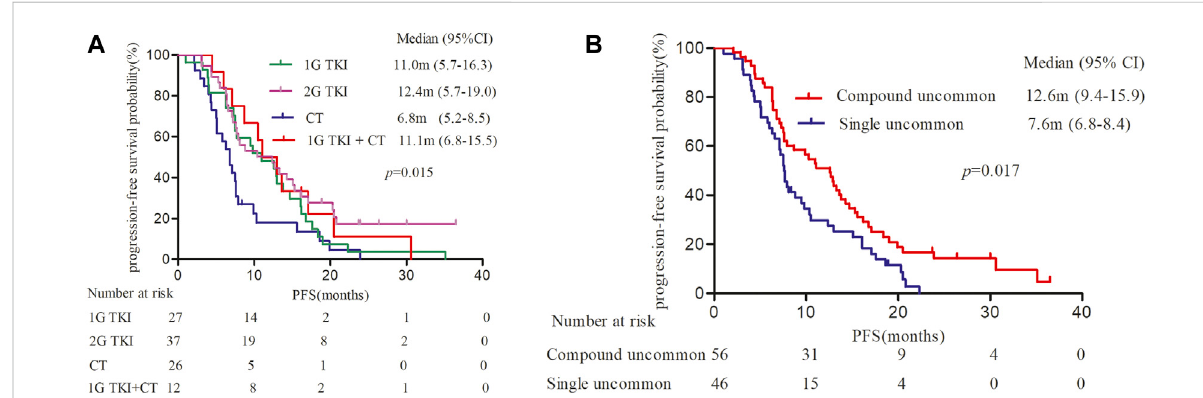
FIGURE 2 Kaplan-Meier curves of progression-free survival (PFS) in patients harboring EGFR uncommon alterations. (A) treated with different treatment modalities. (B) with different uncommon EGFR